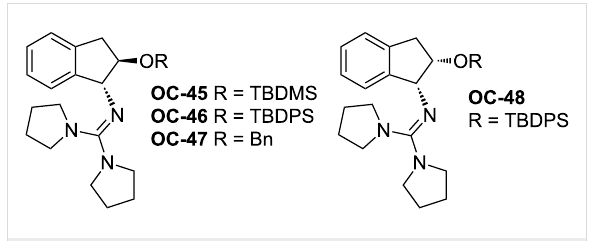
Figure 9: The chiral guanidines ( OC-45 to OC-48